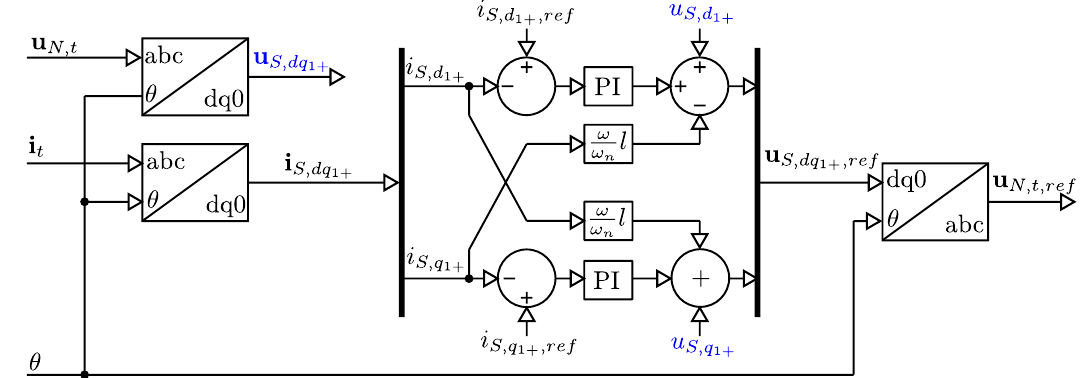
Figure 7. Inverter current control of Figure 4. In order to improve clarity, the connection between u S , d and u S , q are not shown directly but indicated in 1 +